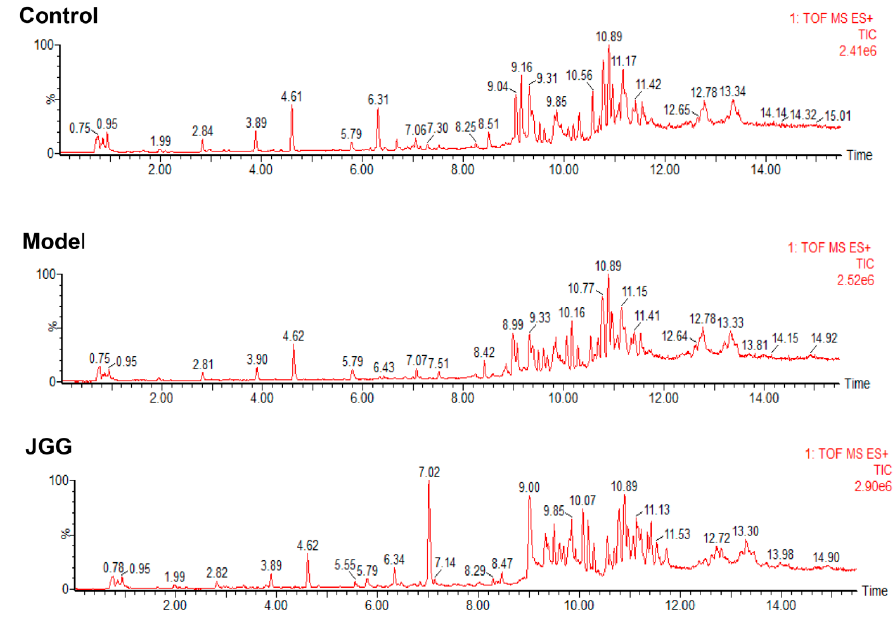
Figure 3. Representative positive TIC chromatograms of serum obtained from the control, model and JGG intervention groups. ( A ) Control group; ( B ) CCl 4 model group; ( C ) JGG intervention group.